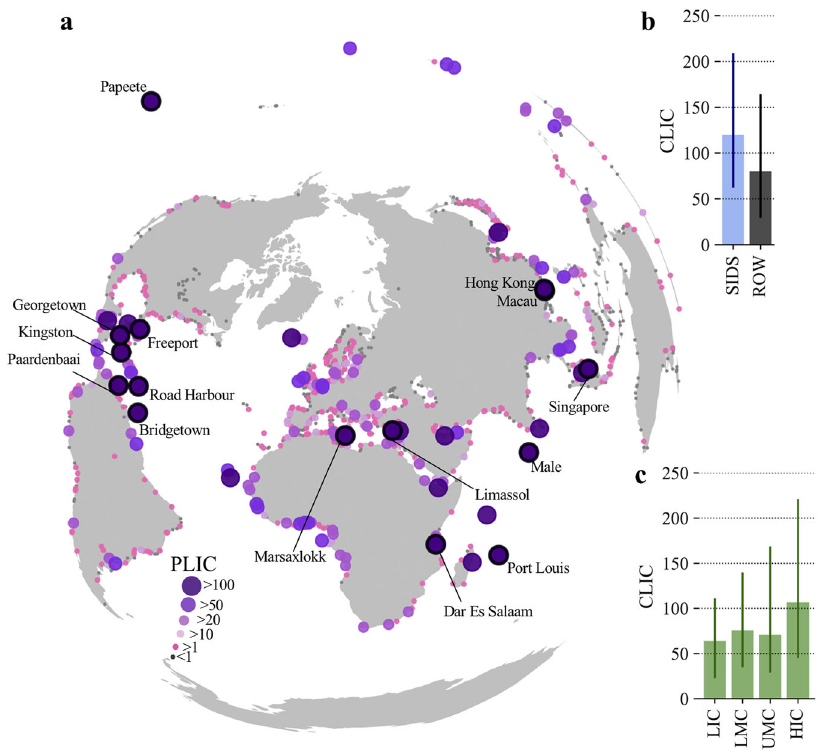
Fig. 6 | Global distribution of the country-level and port-level import coef fi - cient. a The global distribution of the port-level import coef fi cient (PLIC), expressing the USD increase in imports for every 1000 USD increase in fi nal demand. The top 15 ports are highlighted and annotated. b The country-wide maritimeimportcoef fi cient(CLIC)forSmallIslandDevelopingStates(SIDS)andto